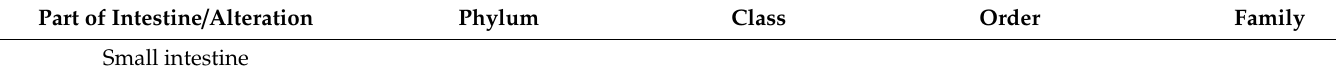
Table 1. The summary of changes in intestinal microbiota